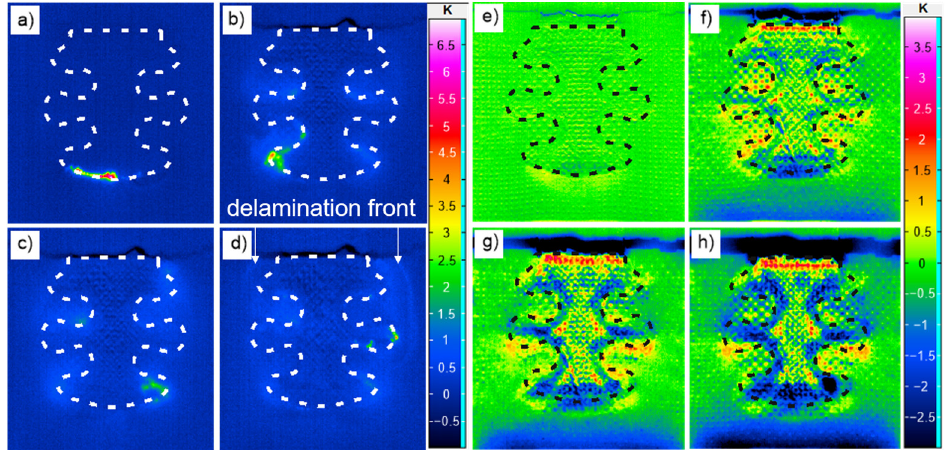
Figure 6. Δ T-thermograms of the hybrid specimens at 23 °C ( a – d ) and 60 °C ( e – h ) in quasi-static